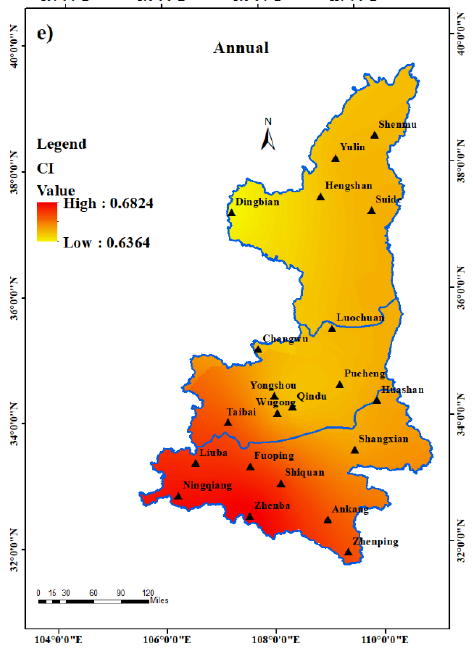
Figure 7. The spatial distribution of the average CI value of ( a ) spring, ( b ) summer, ( c ) autumn, ( d ) winter and ( e ) annually from 1961 to 2020. Table 5. Z value of CI.